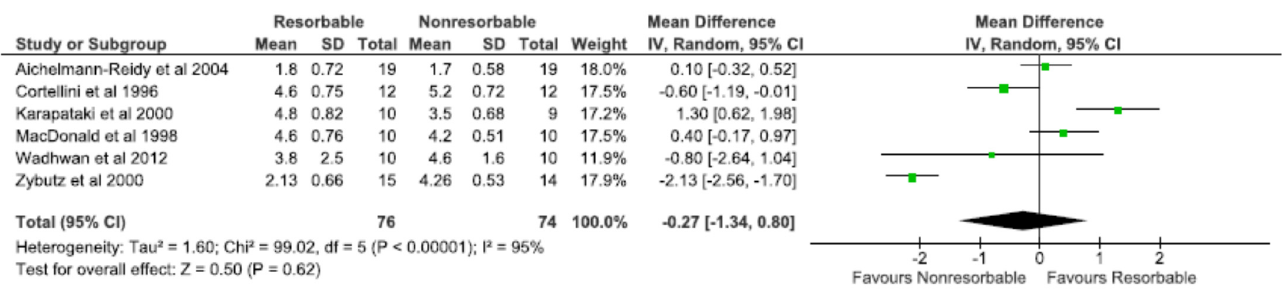
Figure 5. Subgroup analysis of probing pocket depth (PPD) at all intervals (6–12 months).